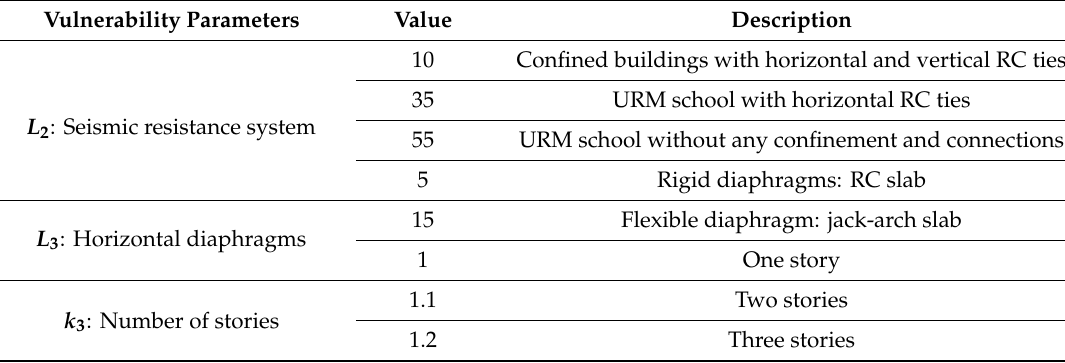
Table 7. Values of parameters L 2 , L 3 , and k 3 [8].